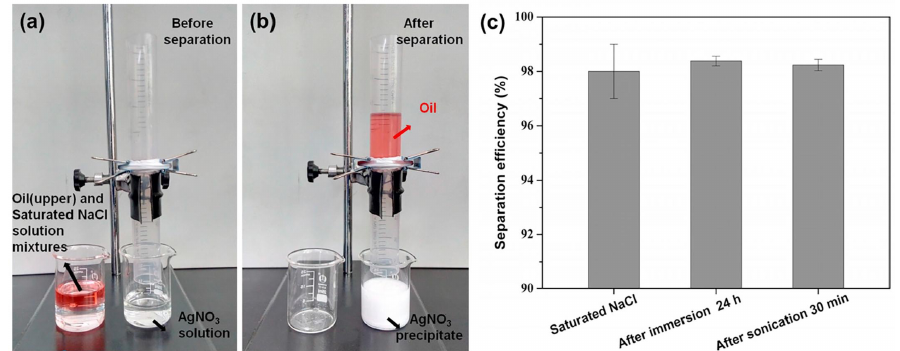
Figure 10. ( a ) The pre-wetted mesh was fixed between two plastic tubes. The mixture of oil (hexane) and saturated NaCl solution stayed layered before the separation. An aqueous AgNO 3 solution was placed in the bottom beaker to detect Cl − in the water phase. ( b ) Photograph showing the collected saturated NaCl solution and blocked oil(hexane) after the separation. The NaCl solution could react with AgNO 3 solution to generate white AgCl precipitate immediately. No obvious, red-colored oil was observed in the AgCl precipitate. ( c ) Separation efficiency of the mesh for the separation of oil/water mixtures in highly salty environment, after immersion in saturated NaCl solution for 12 h, after sonication for 30 min, respectively. Reproduced with permission [142]. Copyright 2018, Elsevier